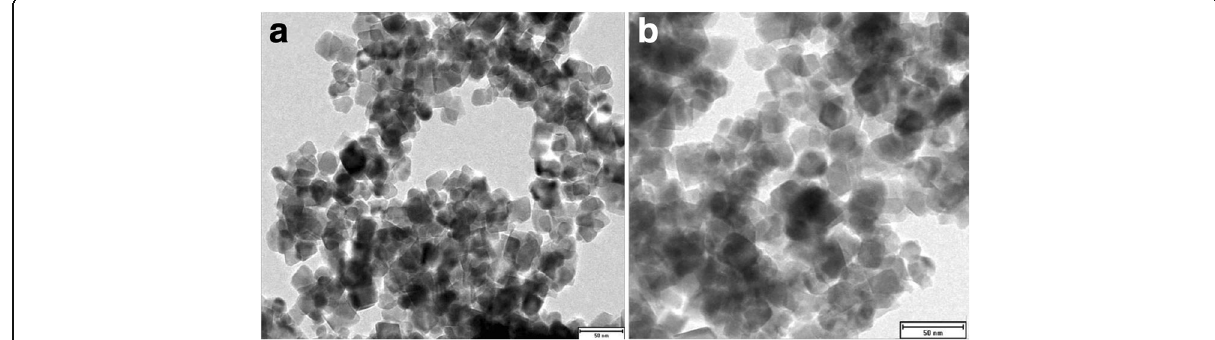
Fig. 1 a , b Transmission electron microscopy (TEM) images of PEG-coated cobalt ferrite nanoparticles collected at different